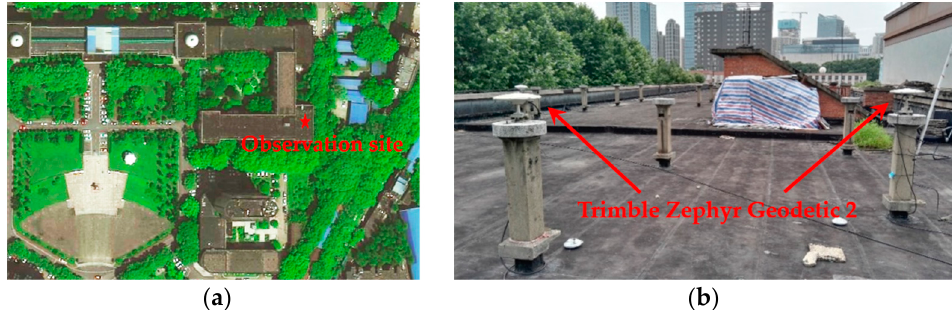
Figure 1. Observational environment and GNSS antennas used in the experiments at SGG building of Wuhan University. ( a ) shows the observation site on the roof of SGG building, and ( b ) shows the Trimble Zephyr Geodetic 2 antenna and the short baseline configuration.